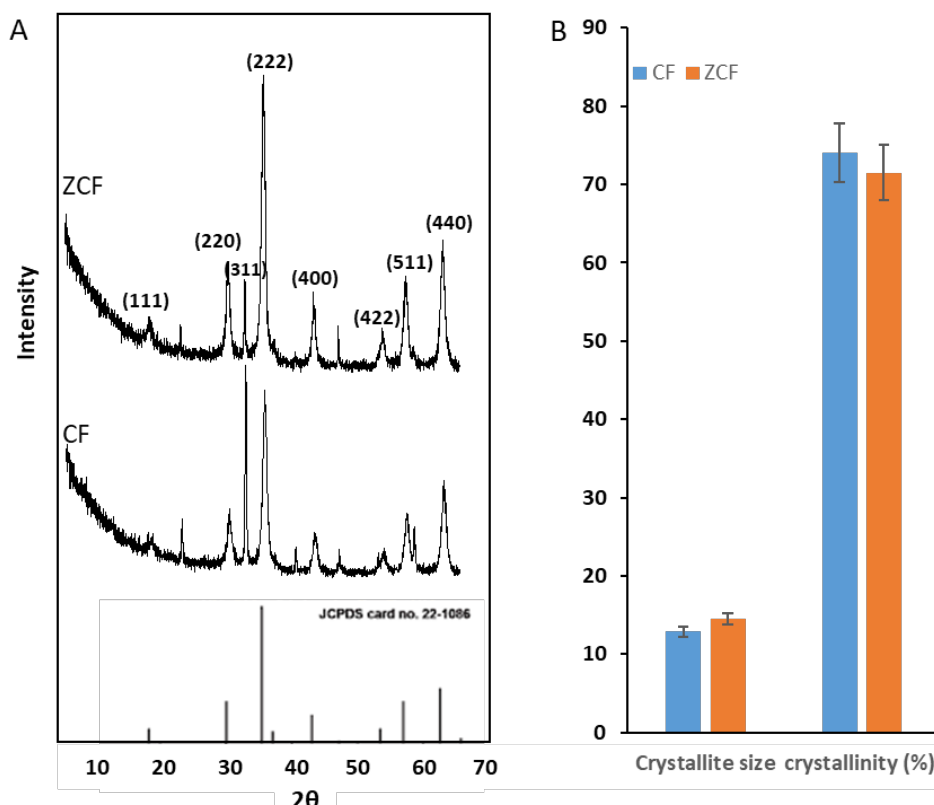
Figure 3. X-ray diffraction (XRD) results for CF-MNPs and ZCF-MNPs, ( A ) average crystallite size (nm) and ( B ) degree of crystallinity (%).